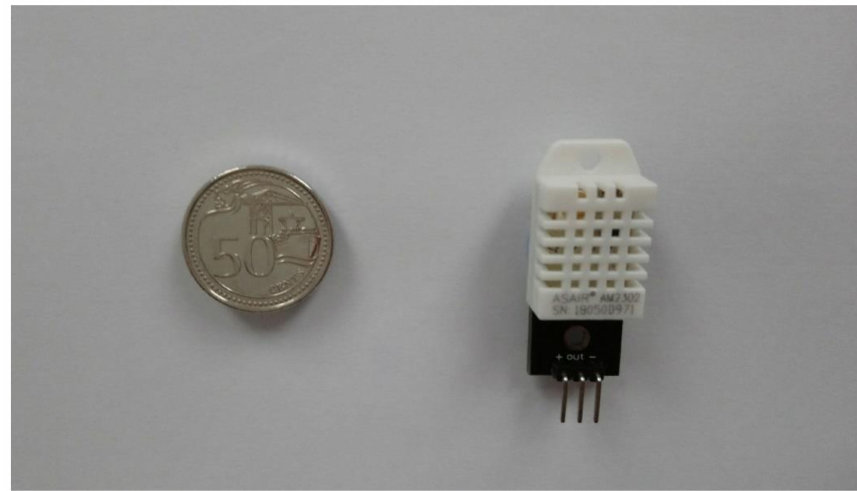
Figure 3. DHT–22 Humidity and Temperature sensor (Aosong Electronics Co Ltd., Guangzhou, China) with breakout board. Singapore 50 cent coin for scaling.